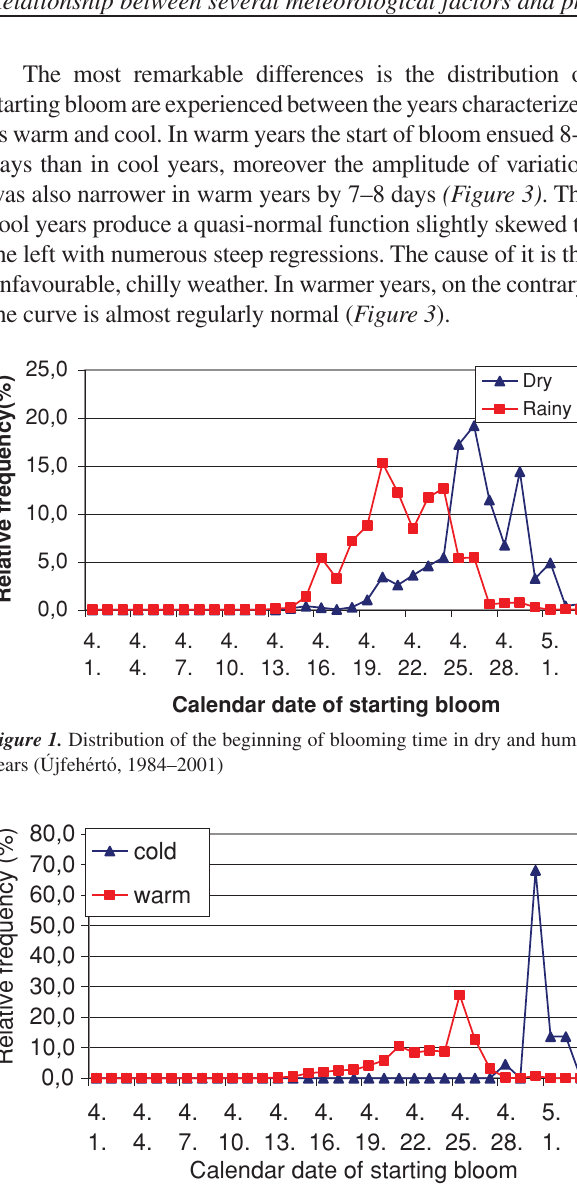
Figure 2. Distribution of the beginning of blooming time in cold and warm